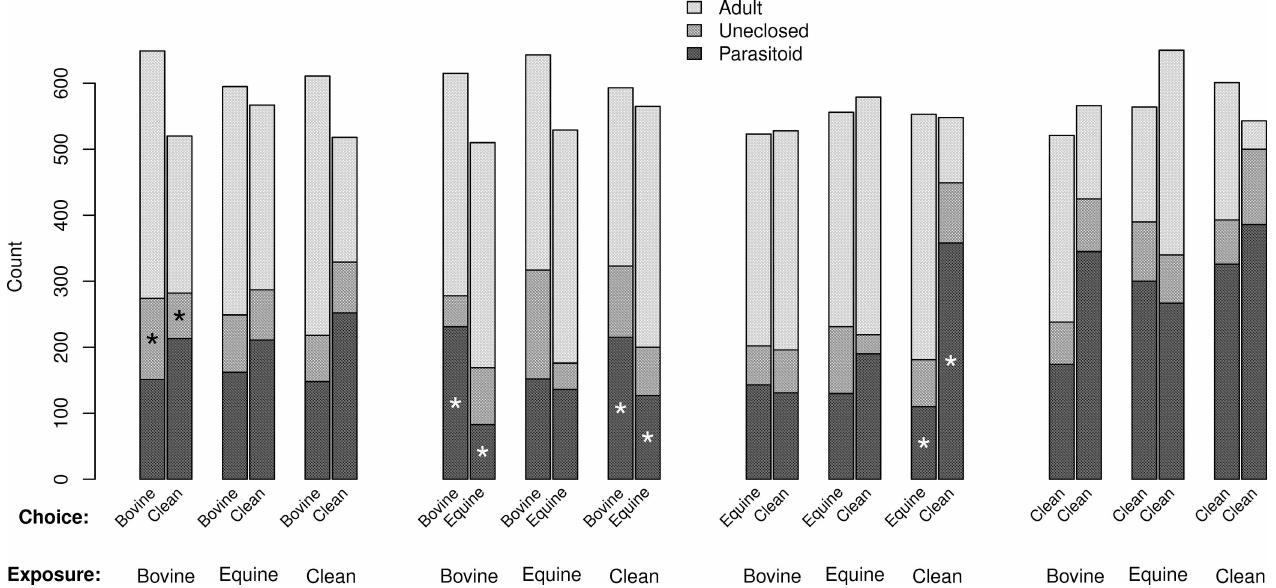
Fig 1. Frequencies of outcomes of house fly host pupa in paired choice tests for 100 female Muscidifurax raptor parasitoids (five replications of 20). Paired bars give choices, with shadinggiving the three possibleoutcomes (adult = adult fly emerges, uneclosed= nothing emerges, parasitoid= parasitoidemerges). Parasitoidswere exposedto one of three conditionsprior to testing (bovine manure, equinemanure, no manure = clean). Asterisks in pairedbars indicate significantdifferences in counts (choicetested as a 1-parametercontrast in a generalizedlinear model assumingan over-dispersed binomialdistribution).